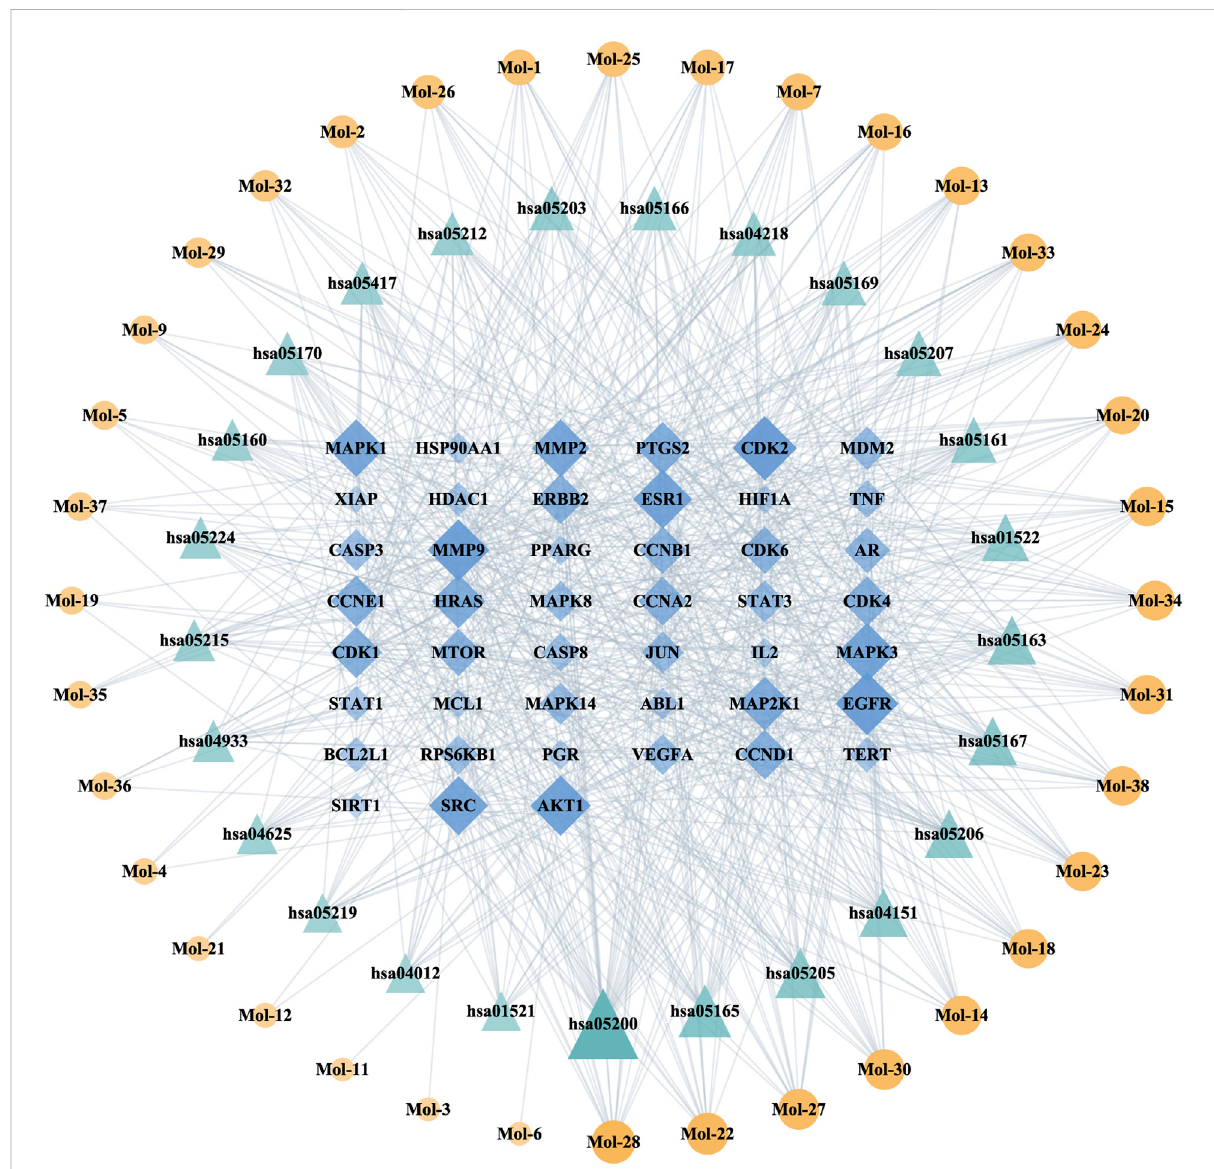
FIGURE 7 Thecompound-target-pathwaynetworkforthetop25KEGGpathwaysinClusterOne.Pathways,compoundsandtargetswererepresentedby greentriangular-,orangecircular-andbluediamond-shapednodes,respectively.ThegreatertheDegreevalueofanodewas,thelargerthesizeand lower the transparency were in the